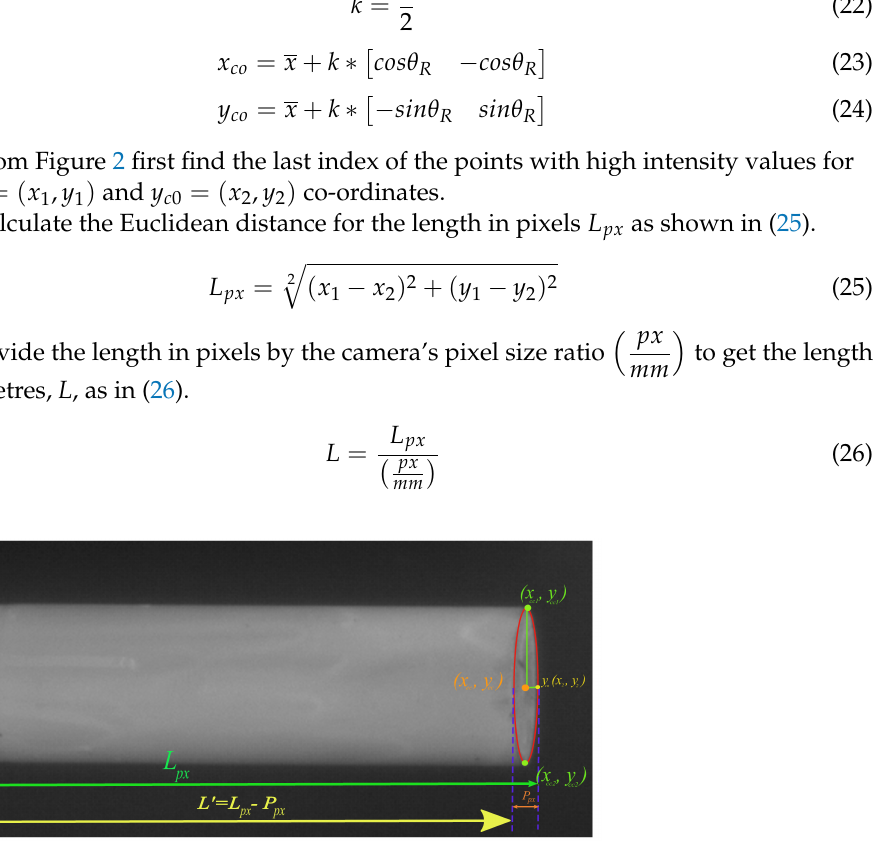
Figure 2. Ellipse fitted over the elliptical part of the cylindrical object along with measured length with and without the perspective